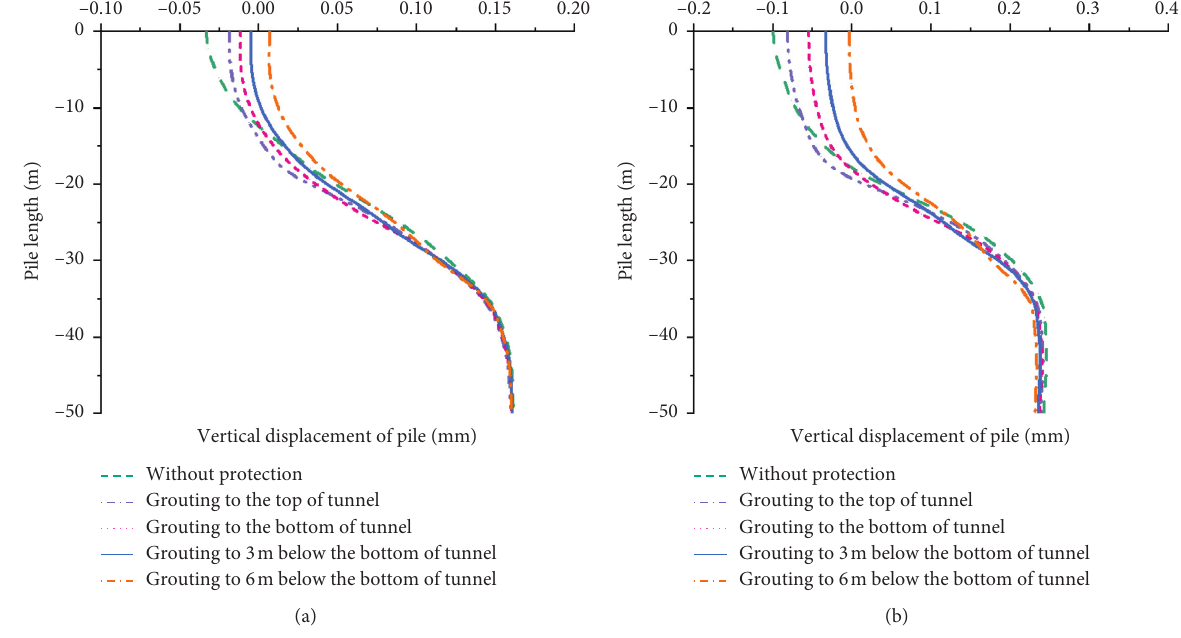
Figure 6: Vertical displacement of the pile: (a) 6 rings before arriving at the pile; (b) 4 rings before arriving at the pile.